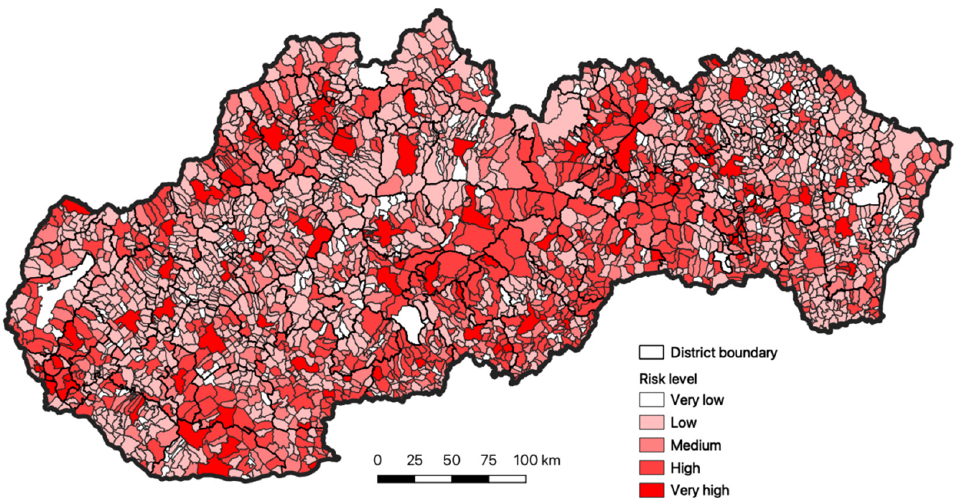
Figure 6. The total evaluation of the risk for the inhabitants of Slovakia to respiratory diseases. Source: Statistical Office of the Slovak Republic, 2020.